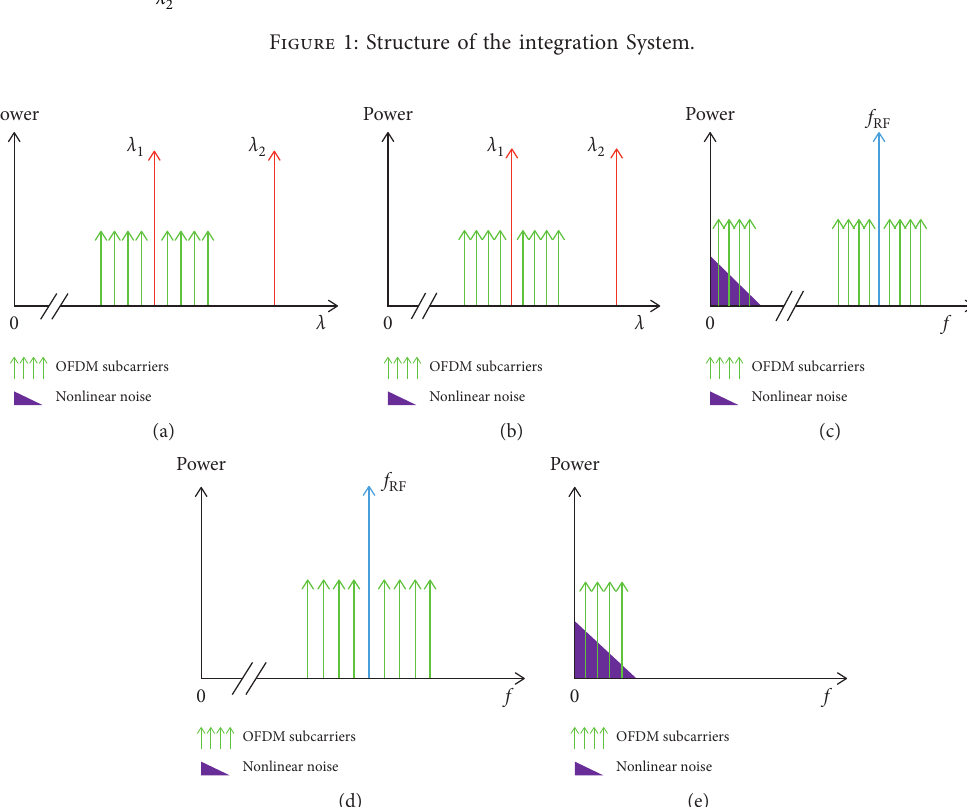
Figure 2: Spectrum diagrams in the integration system. (a) After optical coupling. (b) After FSO link. (c) After the PD. (d) After wireless transmission. (e) After envelope detection.